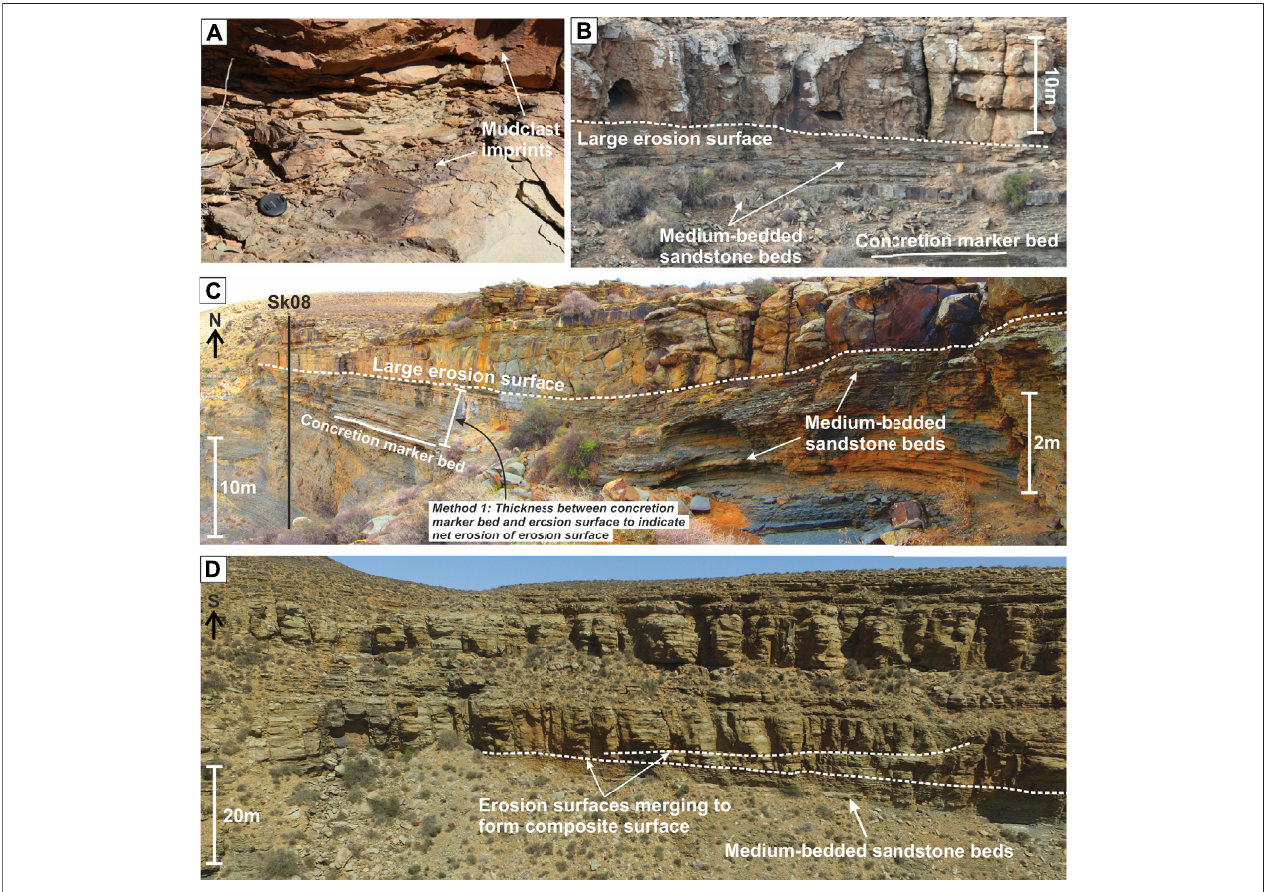
FIGURE 7 | (A) Photo of erosion surface mantled with mudclasts. (B,C) Photos of stratigraphy between concretion marker bed and the erosion surface with medium-bedded sandstone beds highlighted. The location of log SK08 is shown in (C) with the part of the log shown in the photo highlighted in Figure 6 . Method 1 of measuring amount of erosion by the erosion surface is explained in Figure 8 . (D) Photo of the upper sandstone-prone part of the stratigraphy showing multiple erosion surfaces merging indicating the composite nature of this surface.